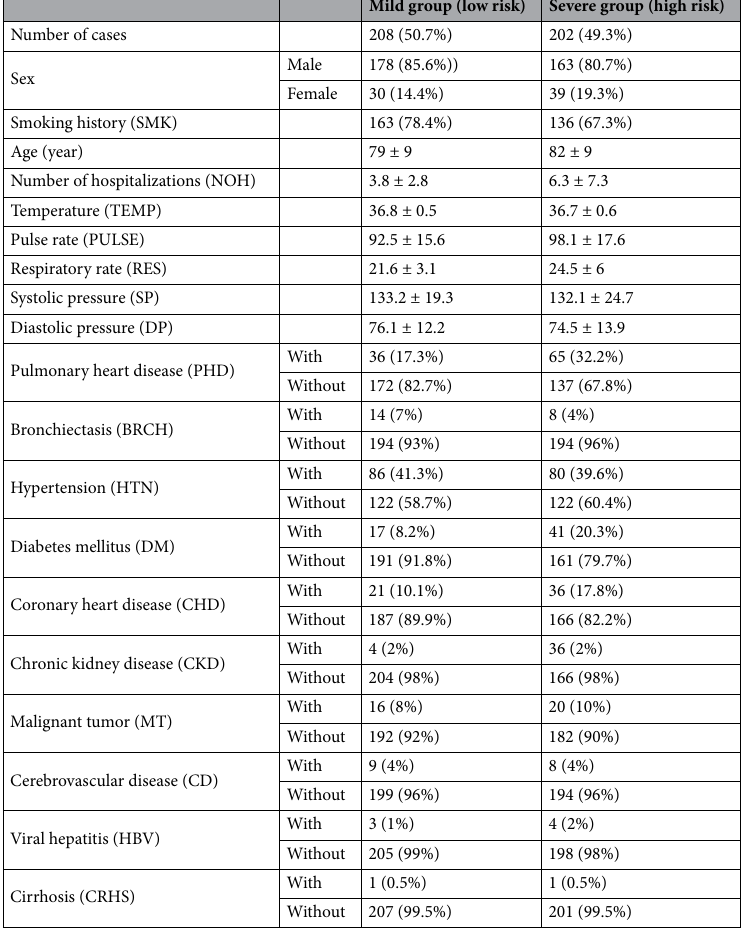
Table 1. A correct version of the original Table